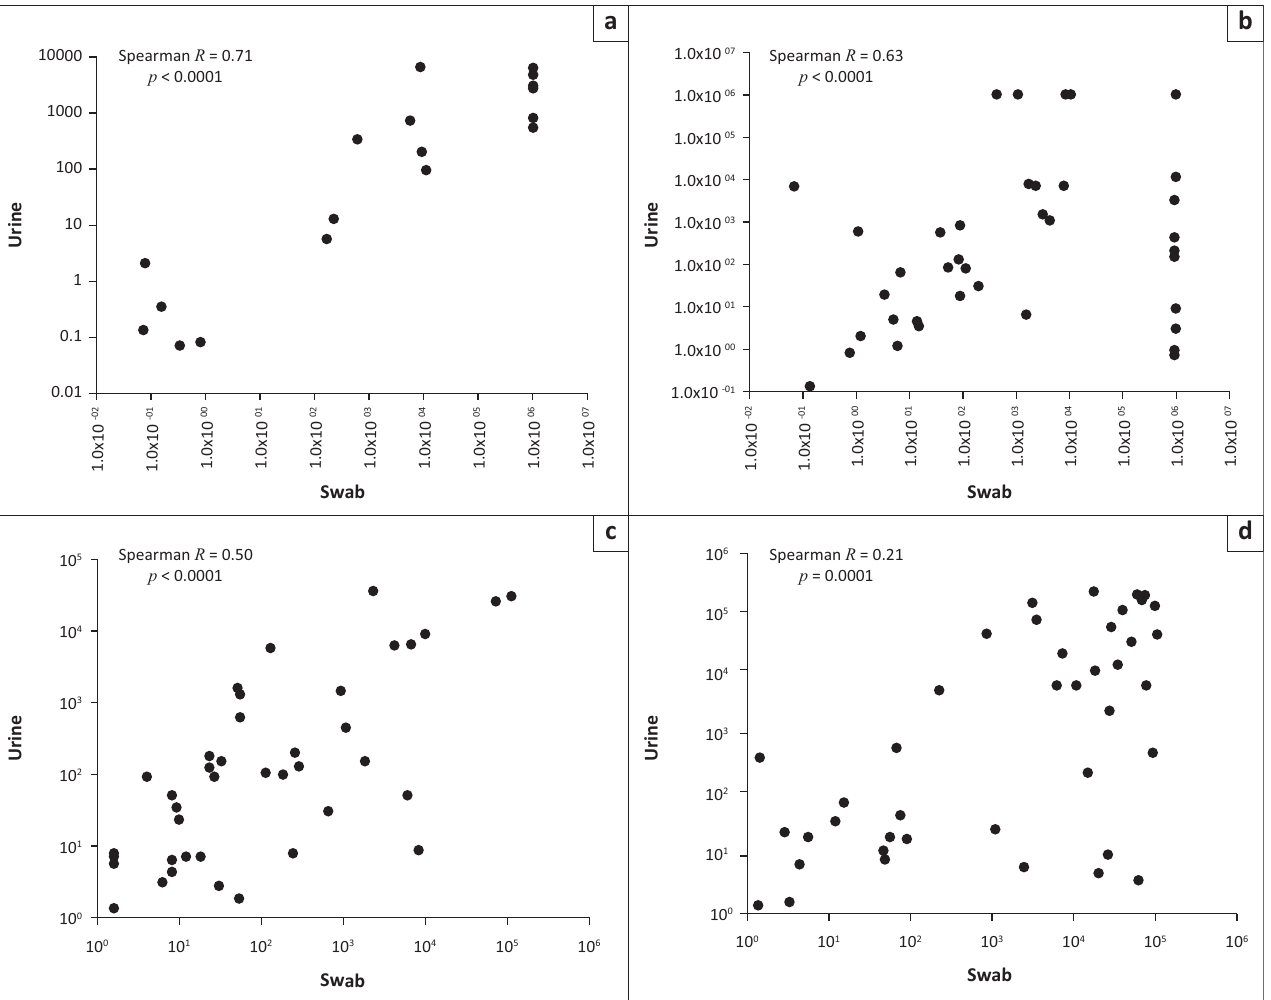
FIGURE 4: The graph on the top left shows the correlation of urine versus swab samples for the detection and quantification of Lactobacillus crispatus . A strong correlation between the sample types, R = 0.71, p < 0.0001, was observed. The plot on the top right shows the correlation of urine versus swab samples for Gardnerella vaginalis . A moderate correlation between urine and swab samples, R = 0.63, p < 0.0001, was observed. The graph on the bottom left displays the correlation of urine versus swab samples for Prevotella bivia as shown here. A moderate correlation between urine and swab samples, R = 0.50, p < 0.0001, was observed, followed by the correlation of urine versus swab samples for Atopobium vaginae . A weak correlation between urine and swab samples, R = 0.21, p = 0.001, was observed. (a) Lactobacillus crispatus, (b) Gardnerella vaginalis, (c) Prevotella bivia and (d) Atopobium